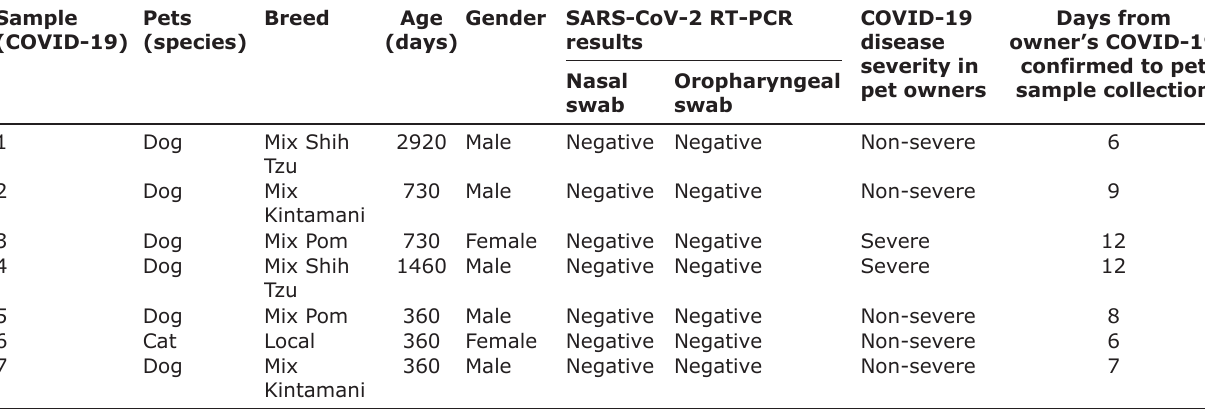
Table-2: SARS-CoV-2 RT-PCR results from seven individual the pets tested. Sample Pets Breed (COVID-19) (species)